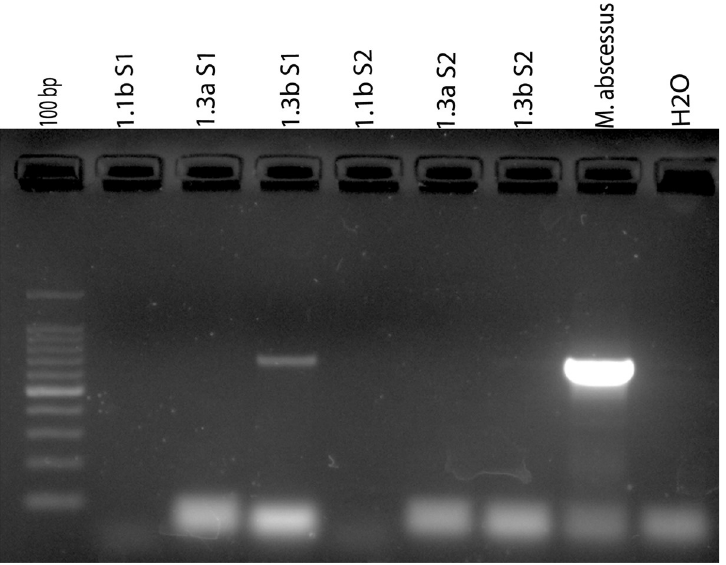
Fig 3. Detection of M . abscessus in gastric biopsy specimens using erm (41) gene PCR. Sample S1 ( 1.3b S1 ) shows amplification for erm (41) gene from the pellet but sample S2 ( 1.3b S2 ) shows no amplification from pellet. There is no amplification in PBS 1 st washed biopsy and supernatant collected after tissue homogenization ( 1.1b S1 & S2 and 1.3a S1 & S2) .